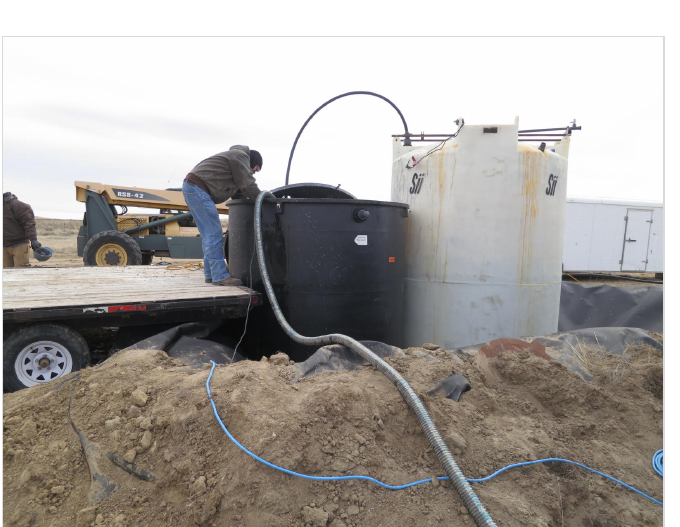
Figure A12. Photo showing 1600-gal mixing tank (black) and 2500-gal feed tank (white) outside of HH 4-11. The arched pipe between the tanks was used to transfer amendment batches from the mixing tank to the feed tank. The feed tank is plumbed directly into HH 4-11 for injections (HH 4- 11 is to the right of this photo).